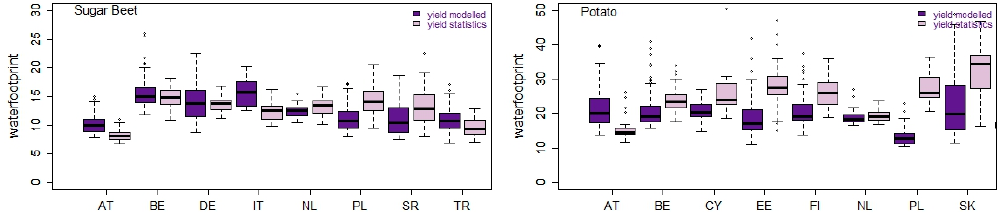
Figure 13. Grey water footprint (in m 3 ∙ Mg − 1 ) for modelled and statistical arable yields for the period 1992–2012 and for four different nitrogen application rates. Note the differences in scale between crops. A two letter code refers to the country that the region belongs to.